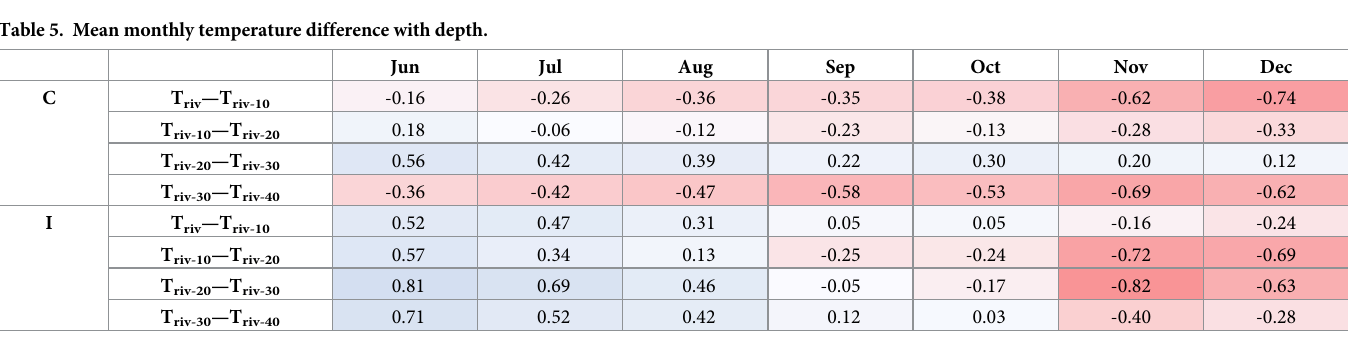
The top row indicates months of the year; letters in the left column indicate site location. Blue cells indicate cooling with increasing depth, red cells indicate warming with increasing depth. Brighter cells, respectively paler cells indicate higher, respectively lower